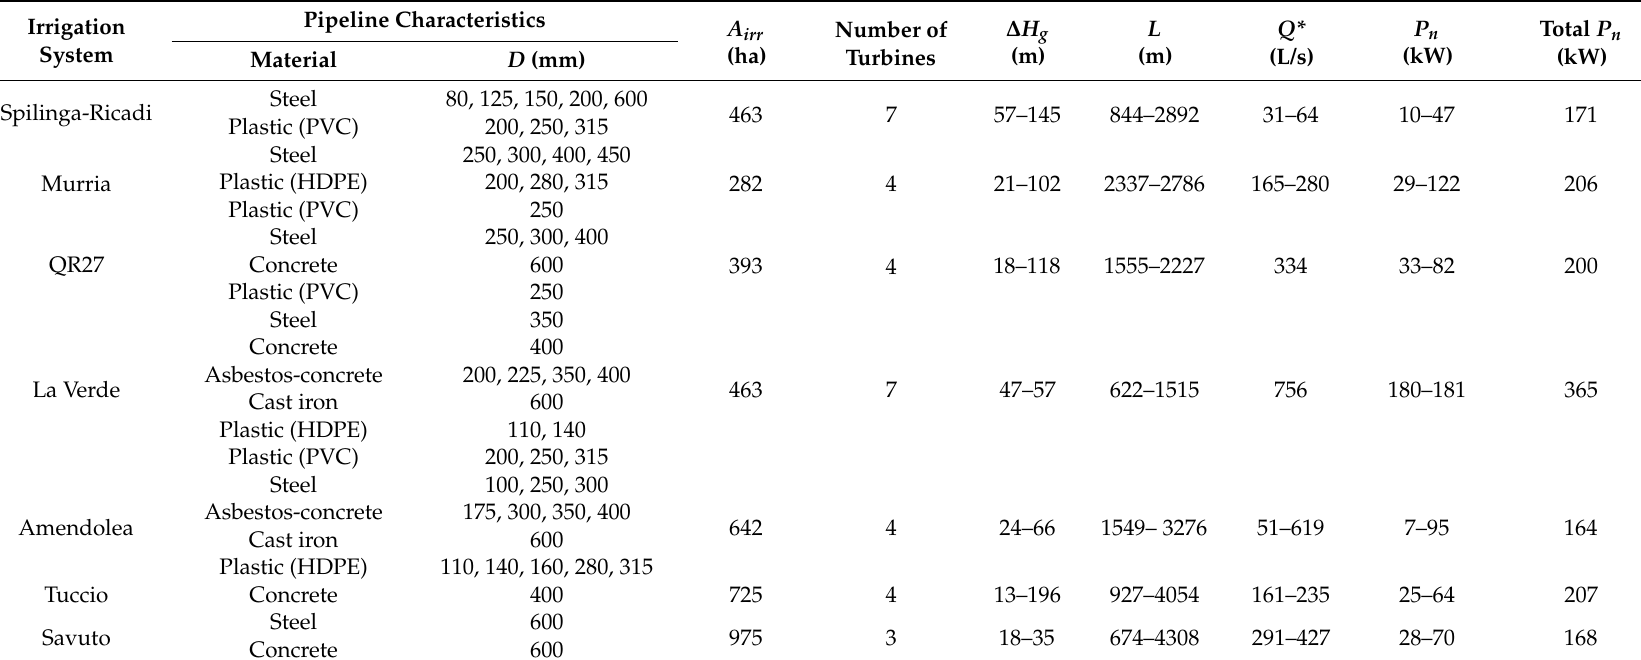
Table 2. Hydraulic parameters and turbine electrical power calculated by the original method for evaluating SHP energy production in seven irrigation systems of Calabria (Southern